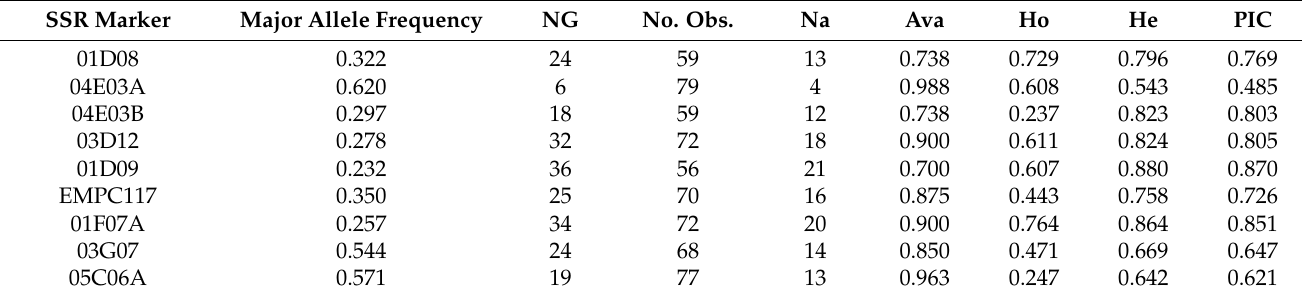
Table 4. Genetic diversity parameters 1 of 80 pear genotypes represented by 13 Pyrus species, 17 Romanian cultivars, and 50 non-Romanian/international cultivars, assessed by molecular marker analysis, using nine SSR